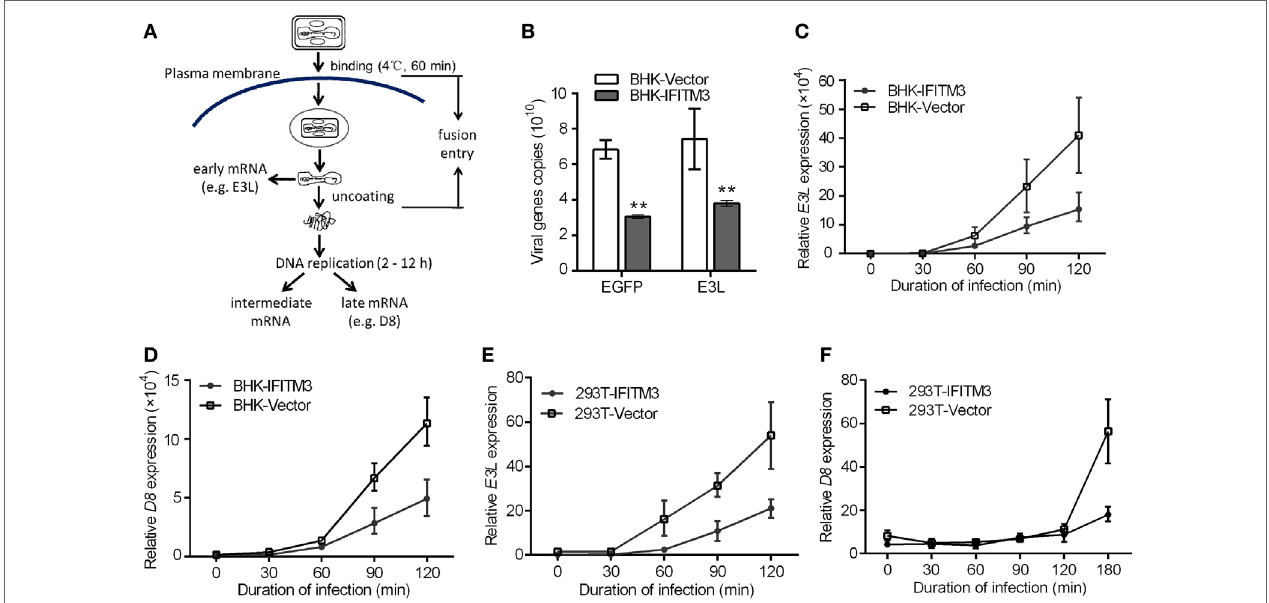
FigUre 5 | Interferon-inducible transmembrane protein 3 (IFITM3) overexpression restricts VACV Tian Tan (VACV) entry. (a) Schematic representation of VACV entry through endocytic pathway. After entry of the VACV core into cells, early genes are expressed, leading to uncoating of the virus core. Subsequently, viral DNA genomes are released, and replication begins within 2–12 h postinfection, which leads to the expression of intermediate and late genes. The transcription of early ( E3L ) or late ( D8 ) genes was used to analyze the early stages of viral infection. (B) Baby hamster kidney (BHK) cells adsorbed by VACV Tian Tan (VTT) were harvested with a cell scraper, and total cell genomic DNA was extracted for quantification of VTT genomic DNA by qPCR. (c–F) IFITM3 + BHK and 293T cells were incubated with VTT at 4°C for 1 h, washed with cold PBS and allowed to rest for 0, 30, 60, 90, and 120 or 180 min before total RNA collection. Virus E3L (c,e) or D8 (D,F) mRNA was quantified by qRT-PCR, and values are presented as the mean ± SD of three independent experiments. * P < 0.05, and ** P <